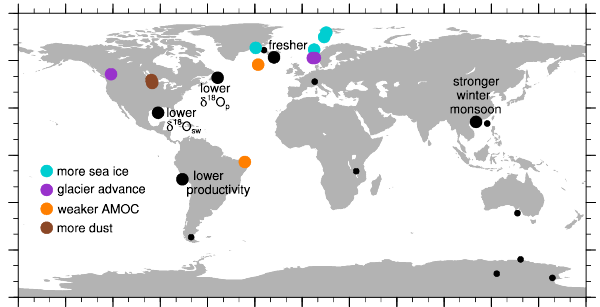
Fig. 5. Climate anomalies relative to early Holocene background climate (defined as the average between 7.4–7.9 and 8.5–9.0 calendar ka) detected near 8.2ka that were not easily categorized in terms of temperature or precipitation. Anomalies observed at more than one site are plotted in color and described by the legend in the lower left, while anomalies observed at just one site are plotted as large black dots and described by accompanying text. Small black dots indicate sites without an identifiable climate anomaly.